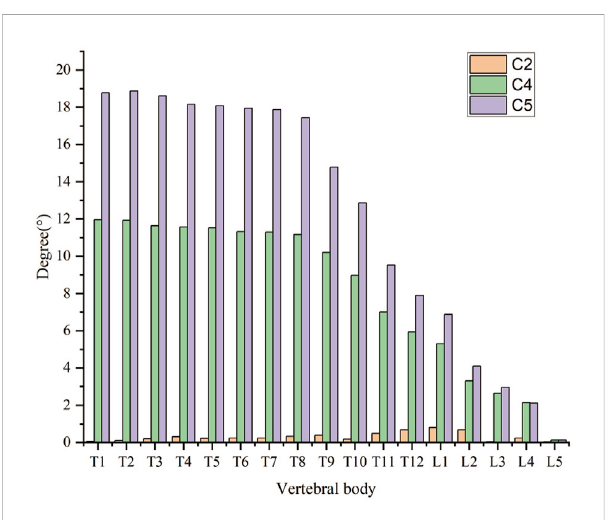
The axis rotation of the vertebral body of the most fl exible spine in C2, C4, and